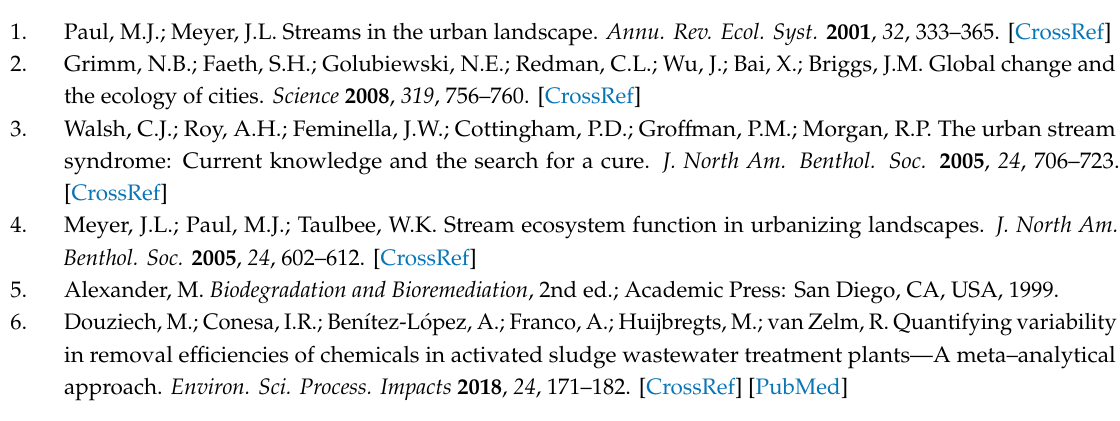
Table S1: Mean, minimum and maximum values of the measured environmental